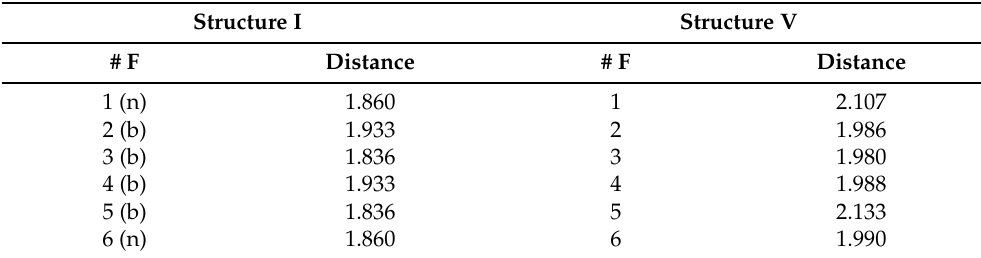
Table 4. Nickel fluorine bond distances (in Å) in the octahedra in structure I and V, respectively. Numbering of the fluorine atoms is the same as in Figure 1. For structure I the bridging and non- bridging fluorines are denoted in parentheses as b and n, respectively. In structure V all the fluorine atoms are bridging and the labels are